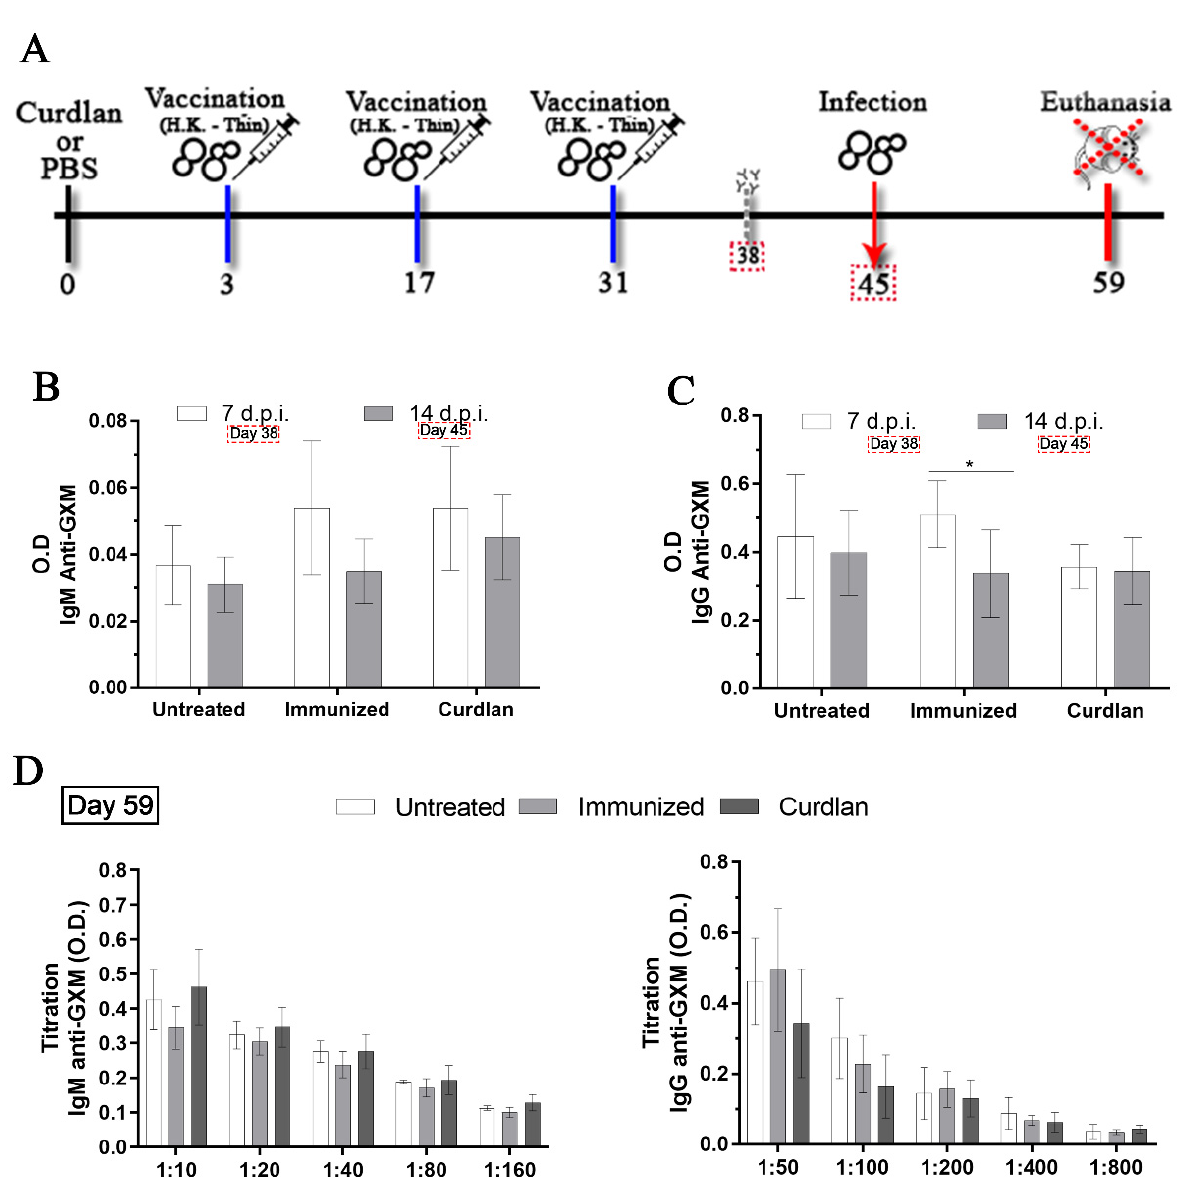
Figure 1. Evaluation of the immunotherapeutic strategy combined with the adjuvant curdlan against C. gattii challenge. ( A ) BALB/c mice were intraperitoneally (i.p.) administered curdlan (200 µ g/mouse) or phosphate-buffered saline (PBS) on day 0. On day 3, they were immunized with 2 × 10 7 yeast cells of heat-inactivated Cryptococcus gattii (HK- C. gattii -thin) or administered